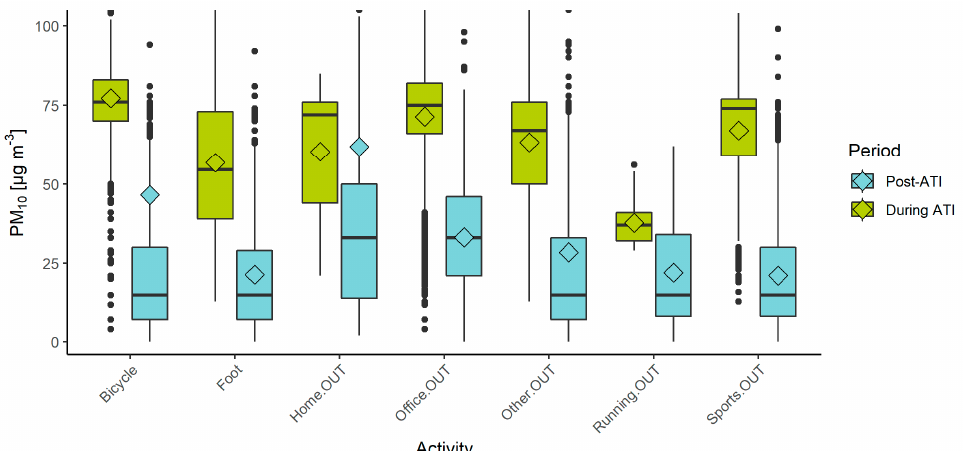
Figure 7. Exposure to PM 10 for different outdoor activities, during (green) and after the period with persistent ATI (blue), collected with the PPMs. Plot limited to 100 µ g/m 3 on the y axis to better illustrate the differences between mean and median